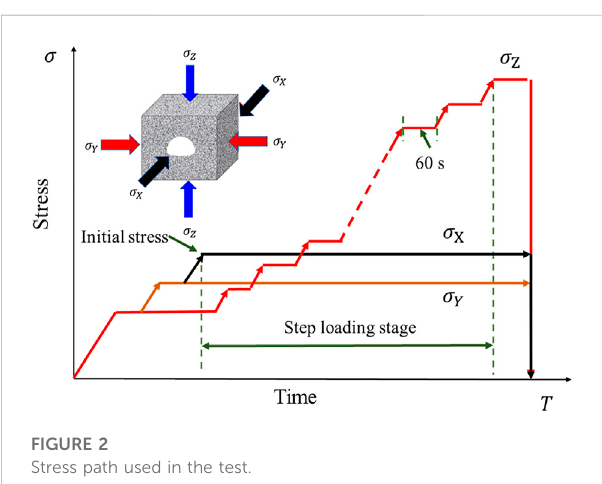
FIGURE 2 Stress path used in the